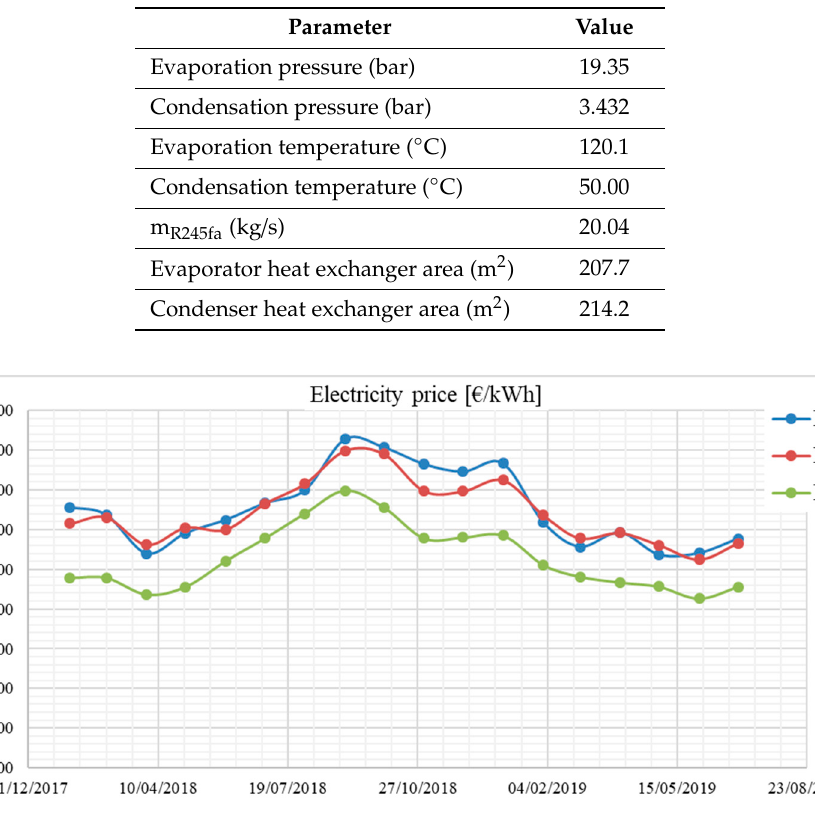
Table A4. Main ORC output parameters.